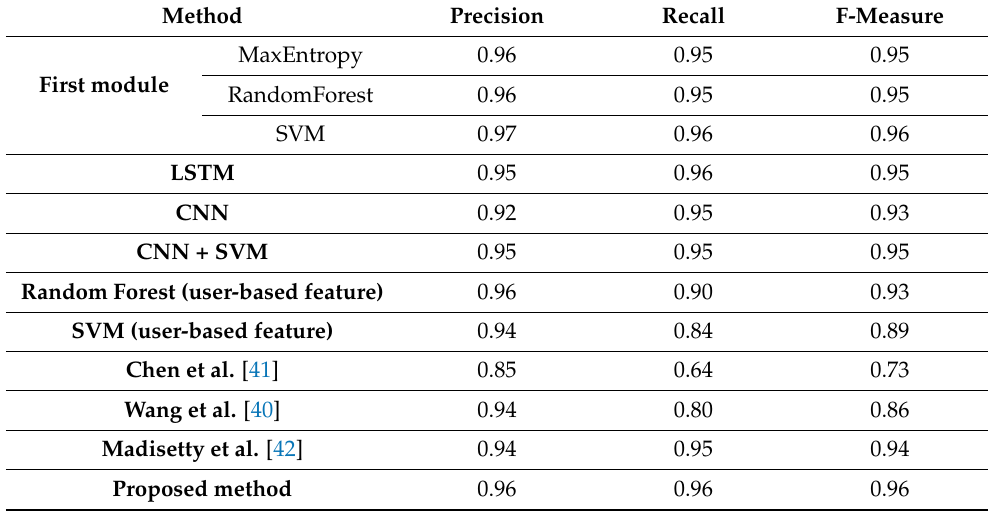
Table 5. Evaluation Results for Dataset 1.